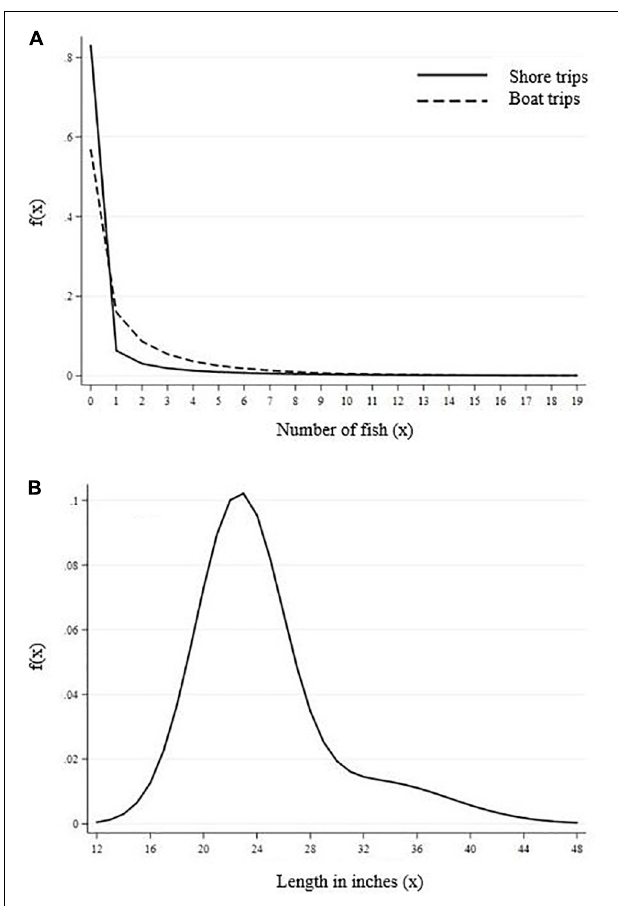
FIGURE 4 | 2015 striped bass catch-per-trip (A) and catch-at-length (B) probability